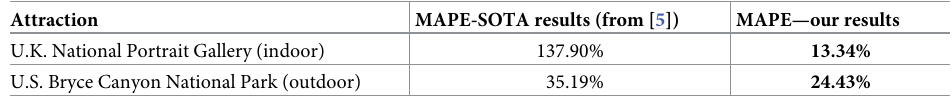
Table 13. Accuracy of difficult cases incorporating explicit tourism prediction requirements in indoor and out- door